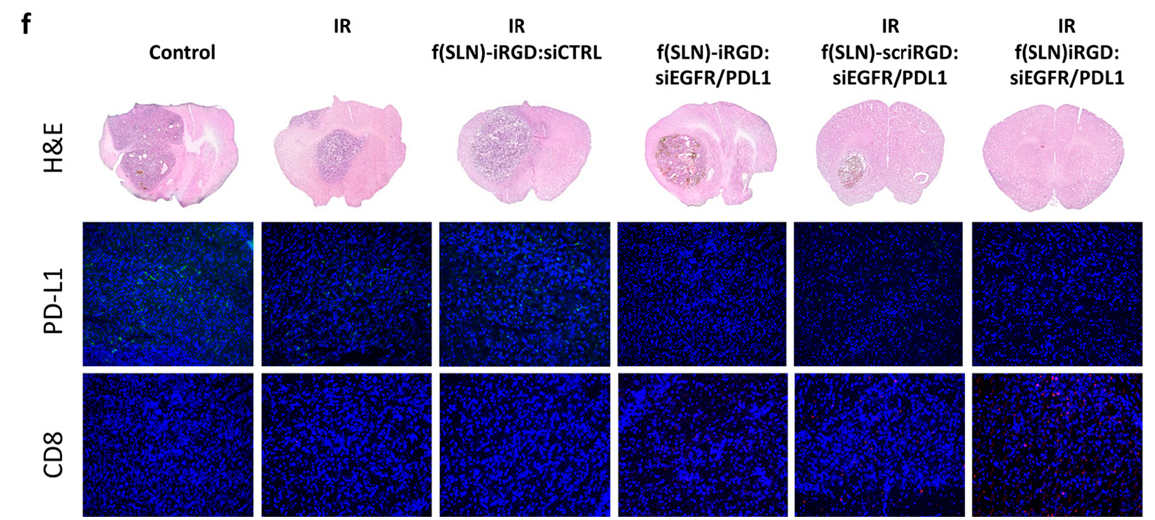
Figure 4. Radiation primes glioblastoma for SLNs targeted delivery. ( a ) Mice bearing GL261-Fluc tumors were irradiated (or not as control) and, three days later, received retro-orbital administration of f(SLNs)-iRGD:Cy5.5 or PBS control. Twenty-four hours post-injection, tumor volume was first evaluated by Fluc imaging (left), and brains were removed and imaged ex vivo for Cy5.5 (middle). The mean fluorescence intensity was calculated and normalized to tumor volume (right; n = 3, * p < 0.05). ( b – f ) Mice bearing GL261-Fluc tumors were irradiated (or not as a control) and retro-orbitally injected with either f(SLNs)-iRGD:siCTRL, f(SLNs)-iRGD:siEGFR/PDL1, or f(SLNs)-scriRGD:siEGFR/PDL1 according to the scheme in ( b ). Tumor growth was monitored weekly by Fluc imaging, and survival was recorded. Images from a representative mouse from each group are shown over time ( c ). Quantification of tumor-associated Fluc radiance intensity with data presented as mean ± SD; * p < 0.05 control vs. f(SLNs)-iRGD:siRNA and control vs. IR + f(SLNs)-scriRGD:siRNA; ** p < 0.01 control vs. IR + f(SLNs)-iRGD:siRNA by ANOVA ( d ). Kaplan–Meier survival curves are shown ( n = 5–12); ** p < 0.01 control vs. f(SLNs)-iRGD:siRNA; ** p < 0.01 control vs. IR + f(SLNs)-scriRGD:siRNA; *** p < 0.001 control vs. IR + f(SLNs)-iRGD:siRNA; ** p < 0.01 IR + f(SLNs)-scriRGD:siRNA vs. IR + f(SLNs)-iRGD:siRNA; by Mantel–Cox (log-rank) test ( e ). H&E staining and immunohistological analysis using anti-PD-L1 and anti-CD8 antibodies on brain sections of a representative mouse from each group (DAPI, blue; PD-L1, green; and CD8, red) ( f ). Reprinted with permission of American Chemical Society from